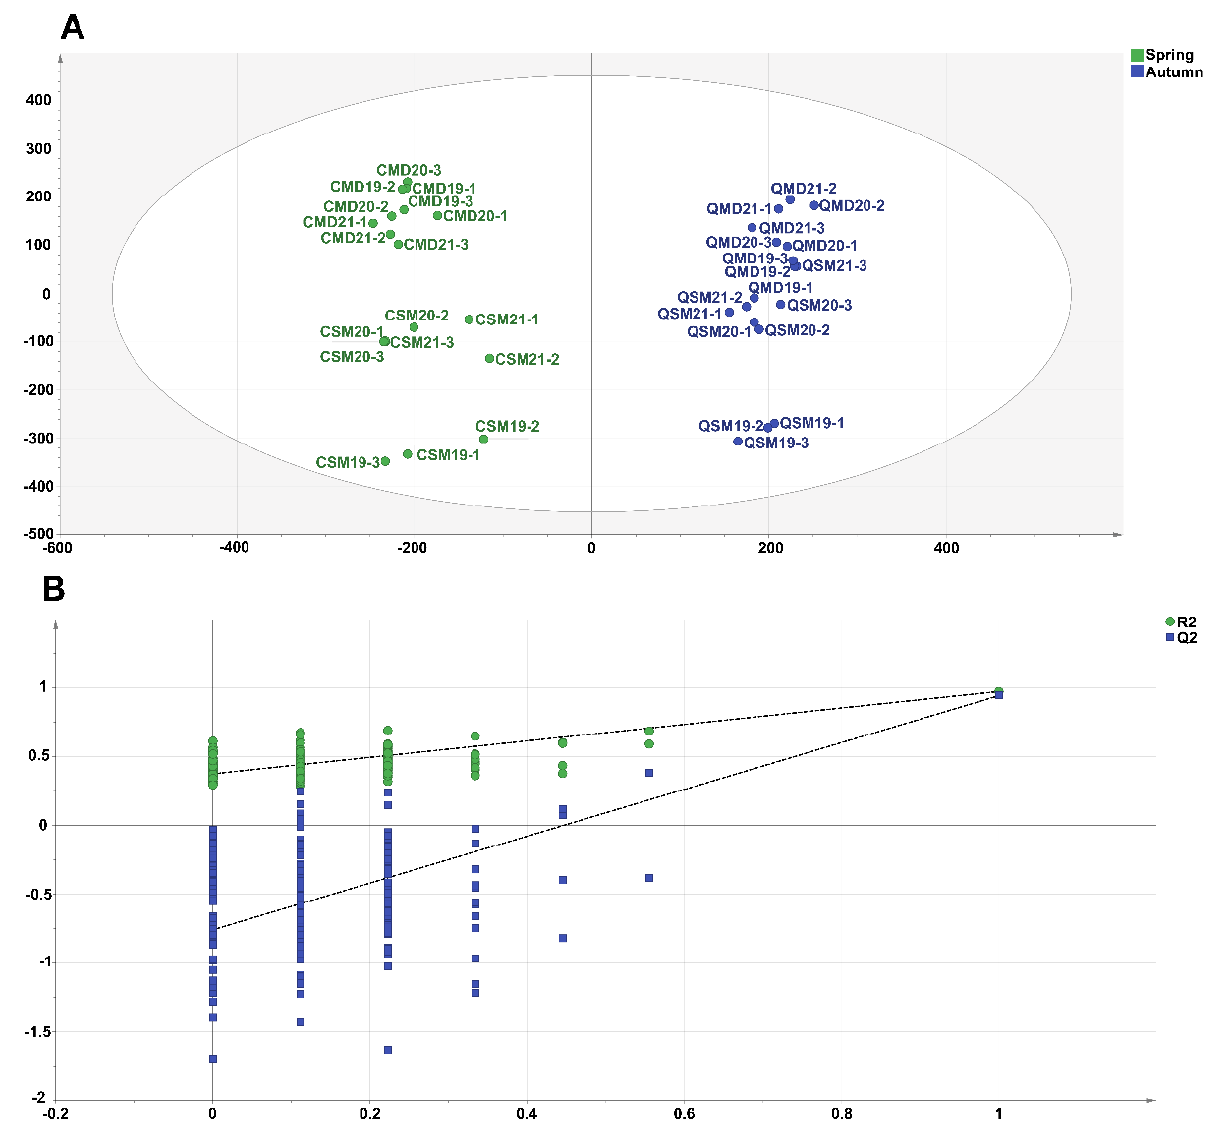
Figure 6. ( A ) OPLS-DA scores scatter plot of volatile components; and ( B ) OPLS-DA cross-validation result of VOCs. White teas picked in spring were called SPWTs and those picked in autumn were called APWTs. White peony teas and Shou Mei picked in spring were termed CMD19-21 and CSM19-21, respectively, while those picked in autumn were correspondingly named QMD19-21 and QSM19-21. The number following CMD, QMD, CSM, and QSM represented the production years, corresponding to 2019, 2020, and 2021, respectively. The number after the year indicates a biological duplicate (Table 1).